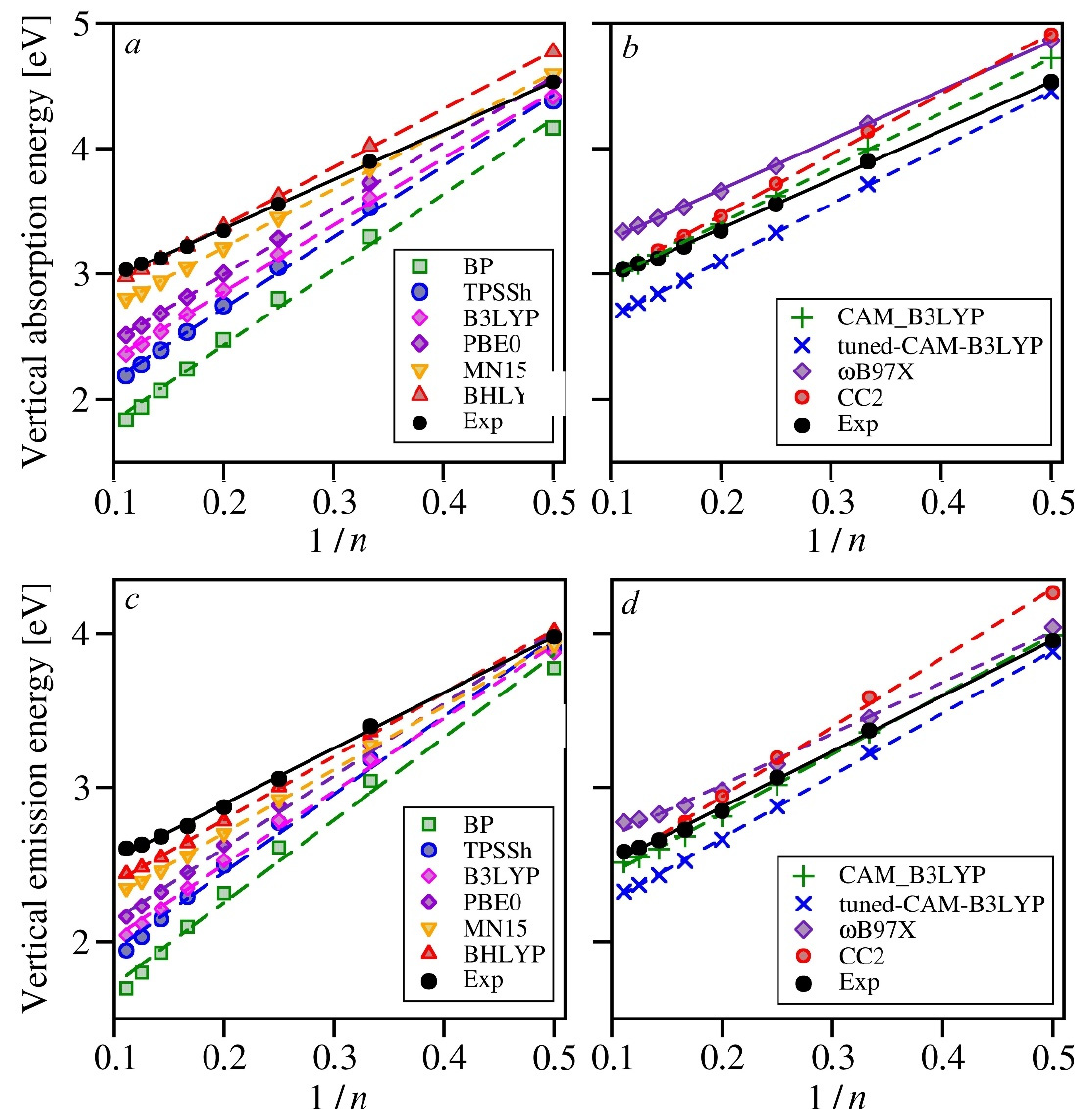
Figure 2. Experimental and calculated values of the electronic transition energies (absorption: panels ( a , b ), emission: panels ( c , d ) for the studied oligofurans with respect to the reciprocal number of rings (1/ n ). Dashed lines represent linear fies to the computed energies. Fitted parameters are collected in Table 4. (For the sake of clarity the results obtained with the GGA and hybrid functionals are shown in panels ( a , c ), while those yielded by the range corrected functionals and CC2 are shown in panels ( b , d ).